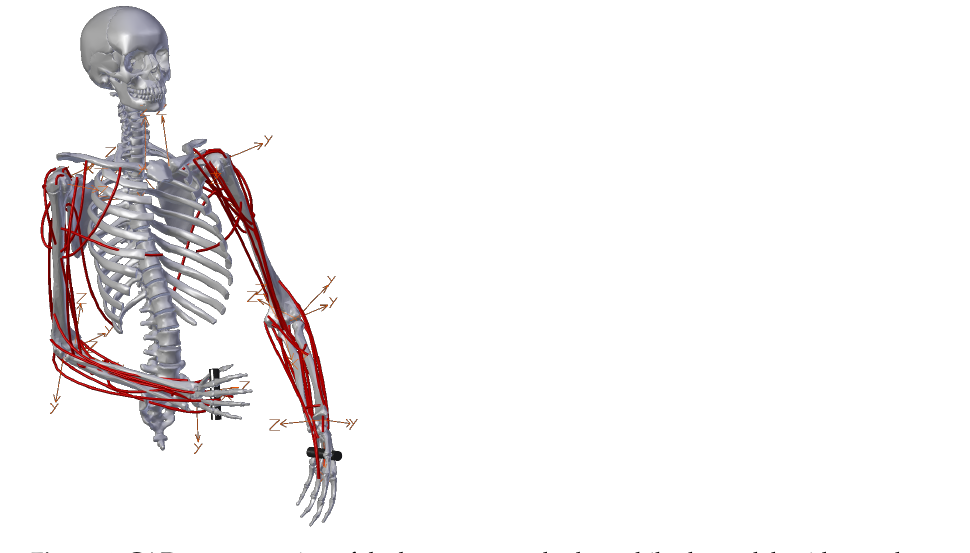
Figure 4. CAD representation of the human upper body multibody model, with muscle actuators highlighted and upper limbs nodes indicated by triads. Vertebral nodes are not highlighted to avoid